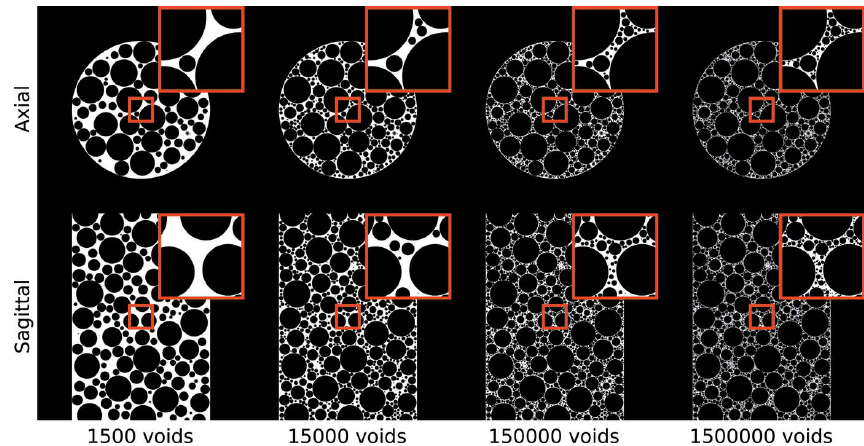
Figure 4 Generated foam phantoms with various numbers of voids. Given are the central axial slice and central sagittal ( i.e. vertical) slice. A small region, indicated in red, is shown enlarged in the top right corner of each